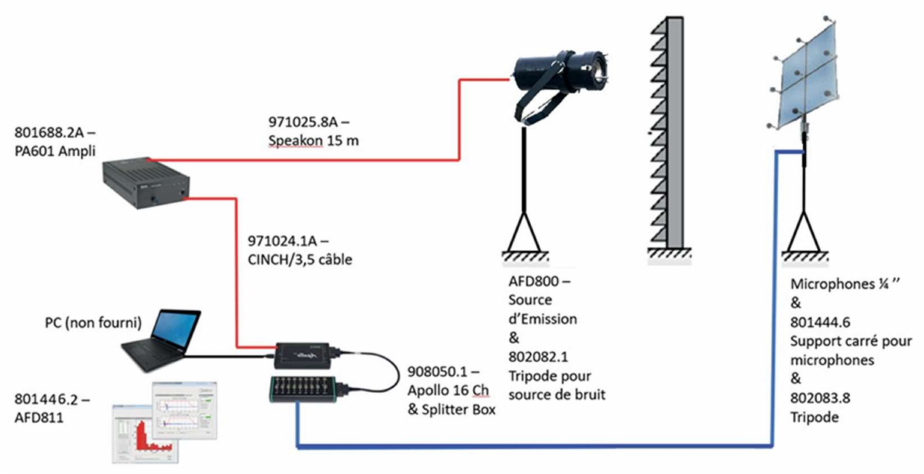
Figure 13. Measurement scheme of a barrier by the Adrienne system [30].